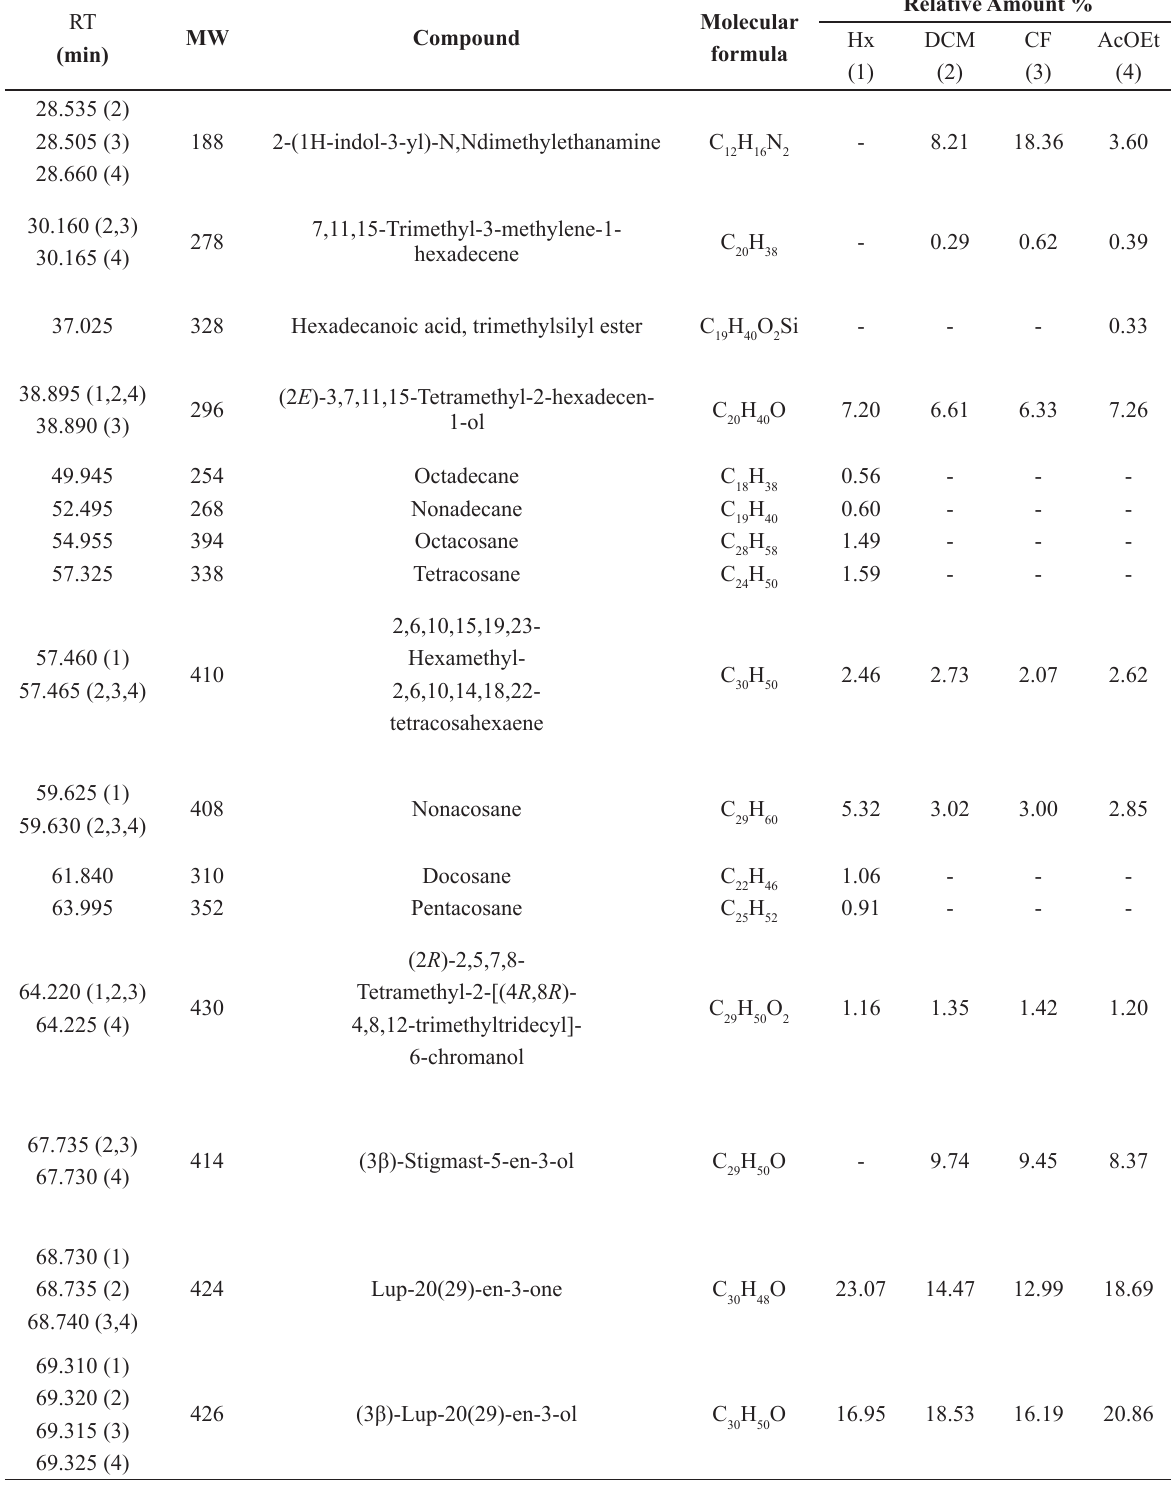
Constituents identified in extracts of leaves of P. microphyllum by GC/MS with the highest similarity indices or equal to